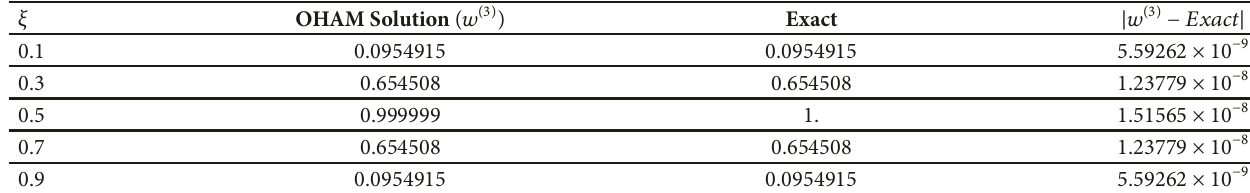
Table 4: Comparison of third-order OHAM solution with the exact solution.